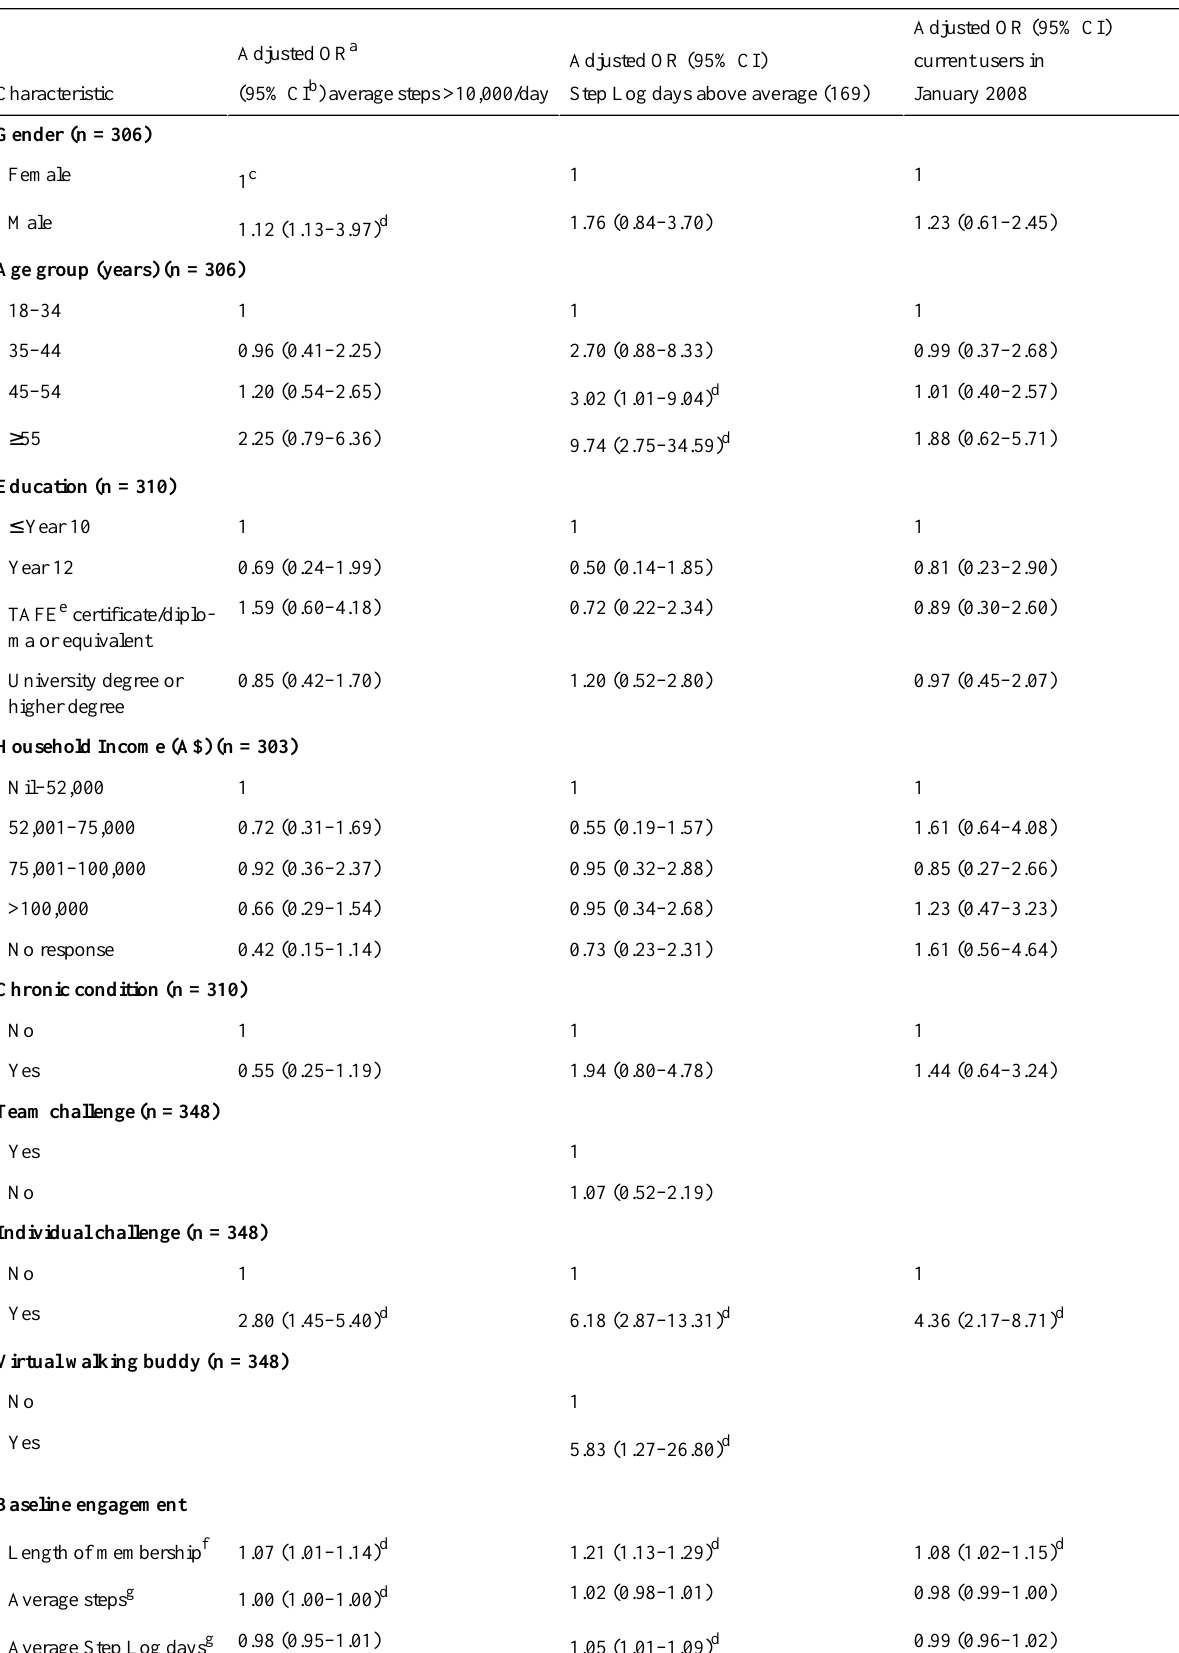
Table 3. Adjusted odds ratios for website